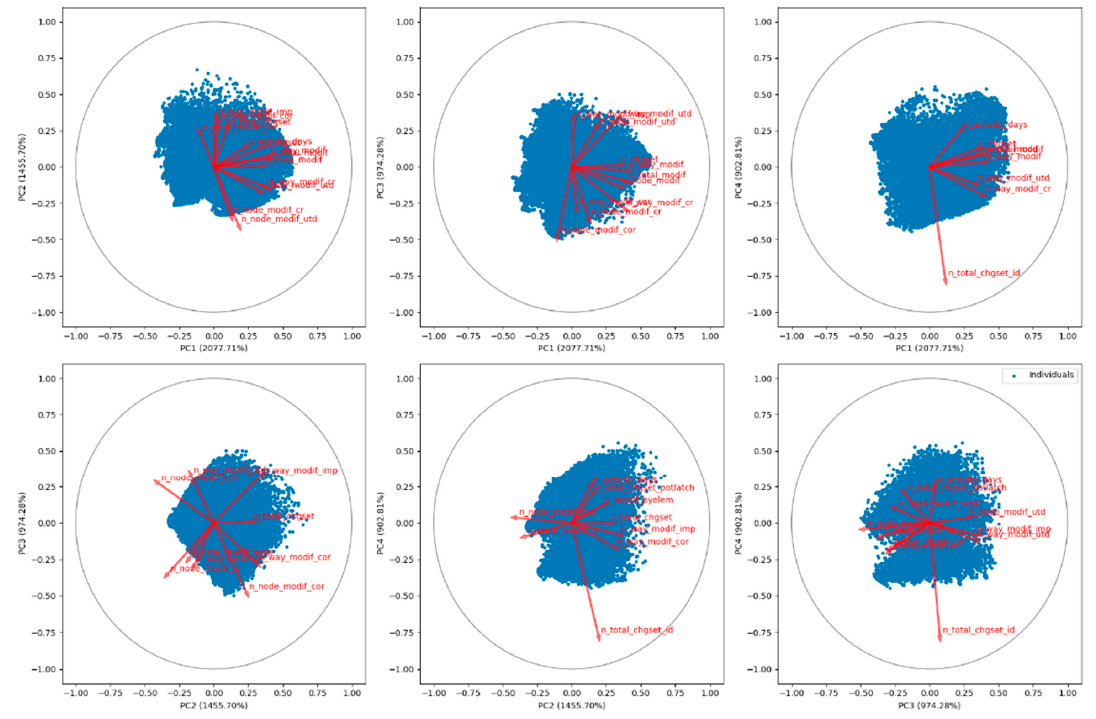
Figure D1 . PCA correlation circle. Figure A1. PCA correlation circle. Table A2. User-based metadata feature contribution for each principal component.